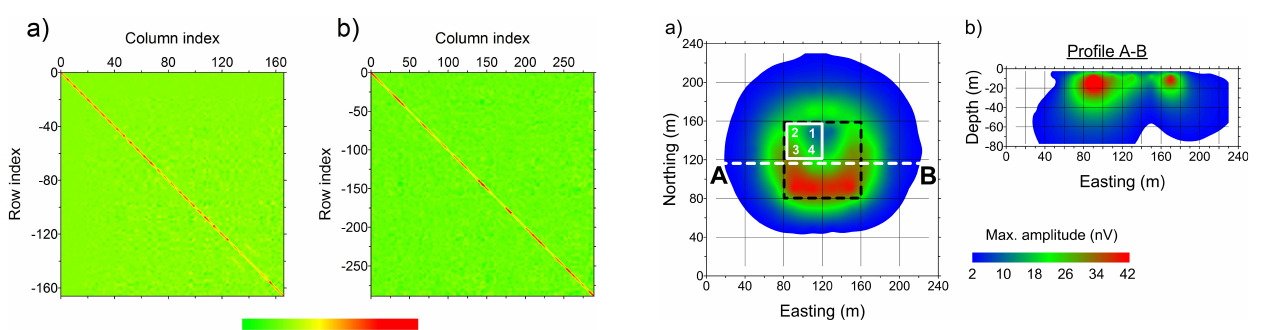
Fig. 5. 3-D sensibility of the SNMR loop computed for 20m × 20m × 10m cells: (a) the amplitude of SNMR signal as a function of the cell location within the loop-affected area computed for the depth of 20m; (b) the amplitude of SNMR signal as a func- tion of the cell location shown as a cross-section along profile A–B. The SNMR loop is shown with a dashed black line and cell size is shown with a white line. Four cells of 20m × 20m × 5m are shown by numbers 1 to 4 within one 40m × 40m × 10m